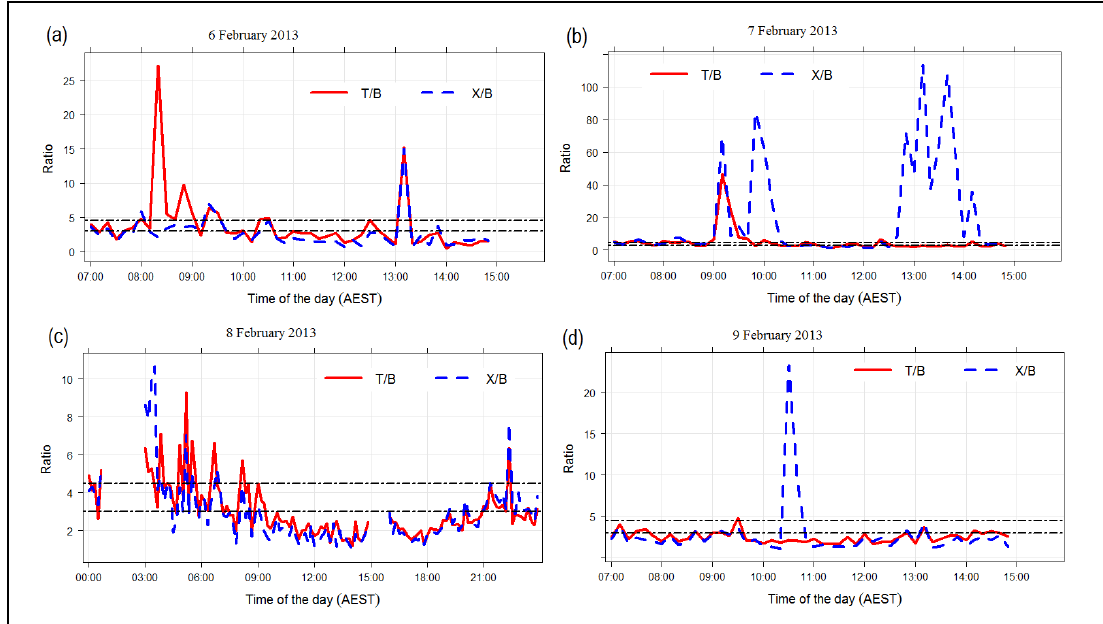
Figure 9. Time plots of the ratios of toluene to benzene (T/B) and xylenes to benzene (X/B) on the four consecutive days (( a ) 6, ( b ) 7, ( c ) 8 and ( d ) 9 February 2013). The black dashed line represents ratio values suggested by Tiwari et al. [80]: Toluene to benzene (T/B) ratios that are greater than 4.5 indicate industrial-originated emission sources [80]. Xylene to benzene (X/B) ratios less than 3.0 imply aged plumes [80]. Note that the y-axes are on different scales. Only measurements from 6:00–15:00 are plotted. Ten-minute averaged data were